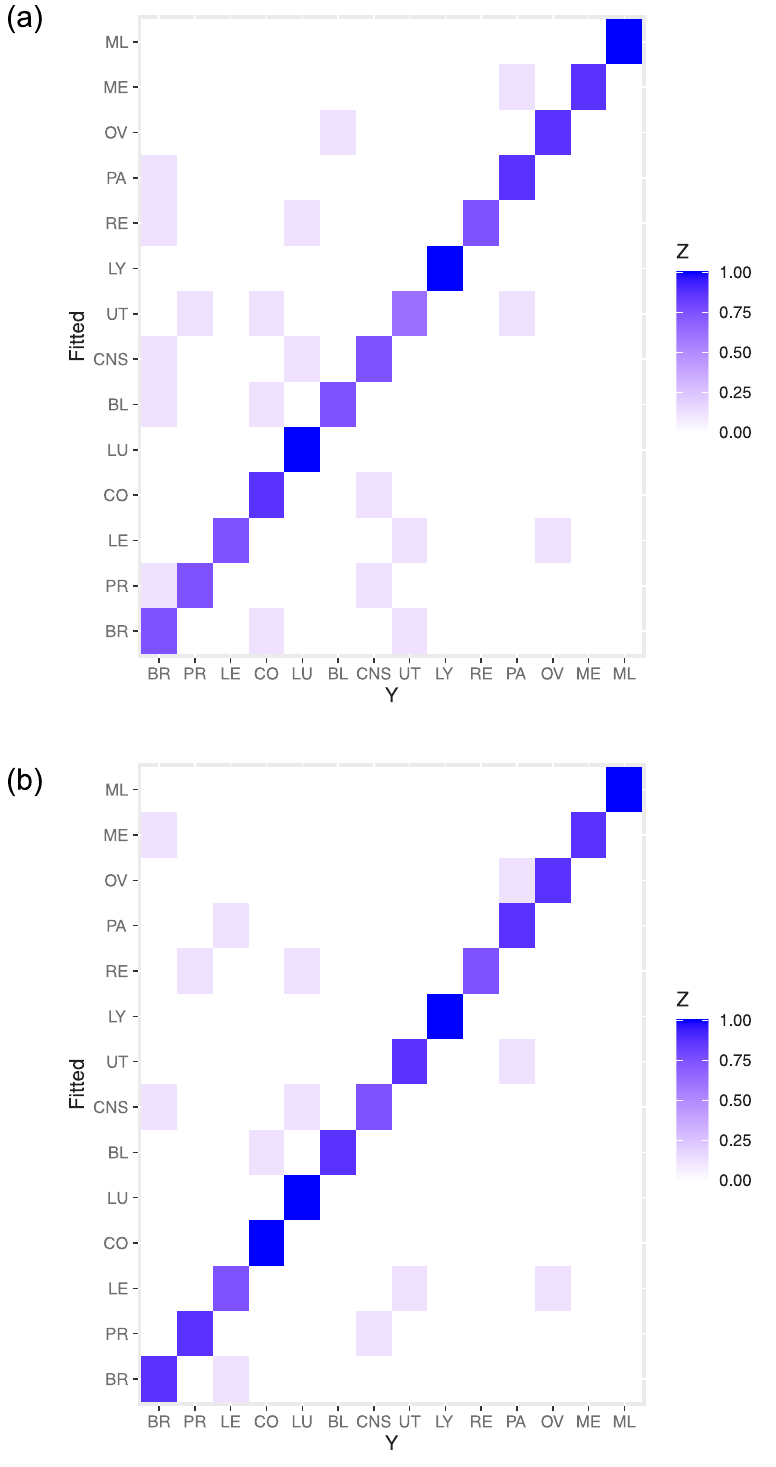
Fig 4. Heatmaps for the fitted values based on two proposed methods under the training data. The left panel is obtained by Algorithm 1, the right panel is obtained by Algorithm 2. Z represents the proportion of (mis)classification.